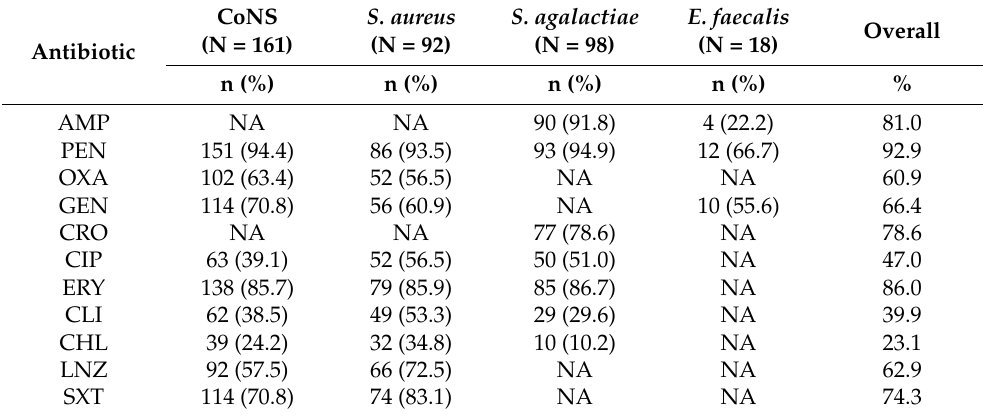
Table 3. Proportion of antibiotic resistance in Gram-positive pathogens causing neonatal